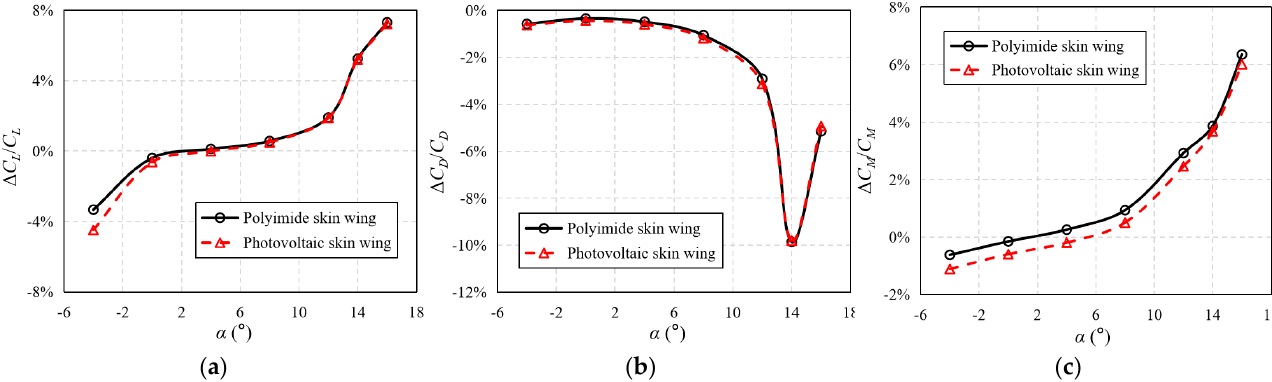
Figure 30. Membrane deformation of the photovoltaic skin: ( a ) Upper surface; ( b ) Lower surface.